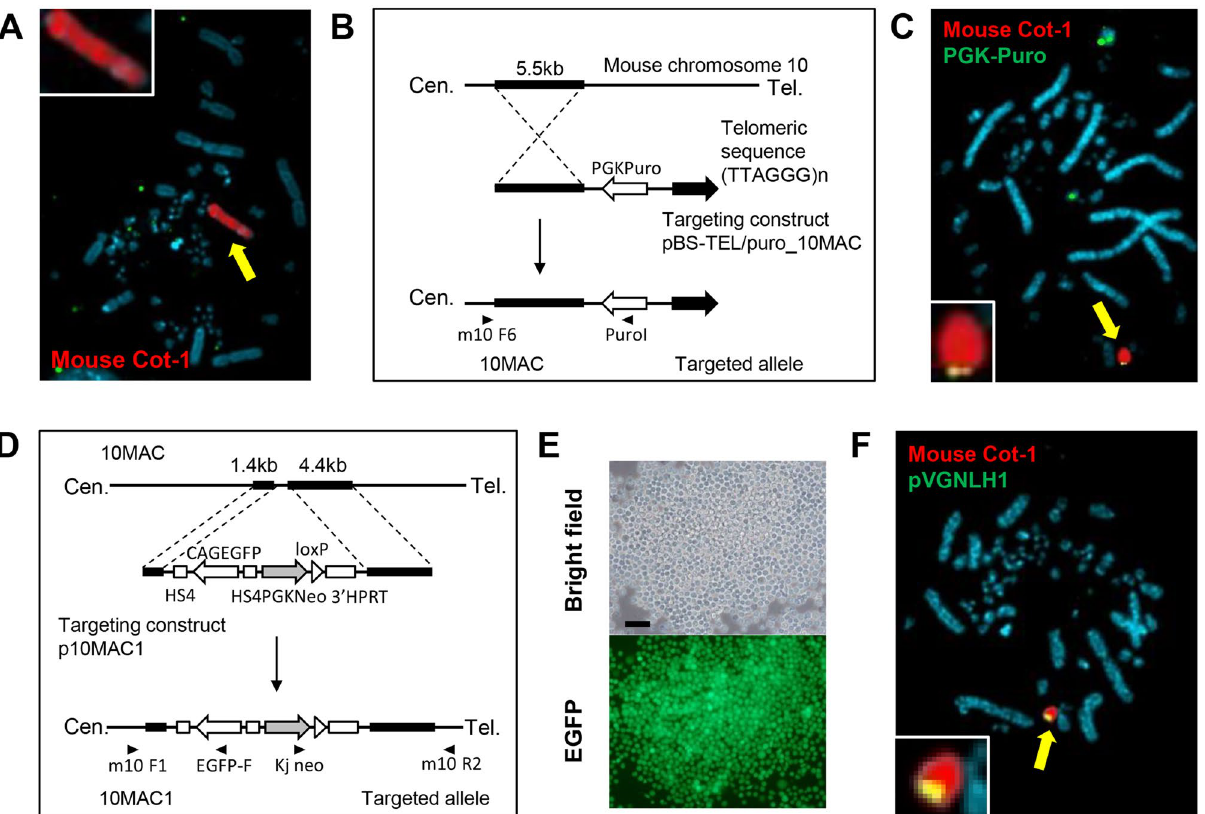
Figure 2. Strategy for the targeted truncation and construction of 10MAC1 vector. (A) Fluorescence in situ hybridization (FISH) analysis with a digoxigenin-labeled mouse Cot-1 DNA (red) identified the intact mouse chromosome 10 in the DT40 cells. The arrow indicates an intact mouse chromosome 10 and the inset shows an enlarged image. The chromosomal DNA was counterstained with DAPI, and DAPI was used for the same purpose in the following FISH experiments. (B) Strategy for the targeted truncation of the distal region of mouse chromosome 10 by the targeting vector, pBS-TEL/puro_10MAC. The telomere-seeding vector was electroporated into DT40 cells containing mChr.10-NeoR to yield puromycin-resistant transfectants. Arrowheads indicate genomic PCR primers. (C) A two-color FISH probe comprising the mouse Cot-1 DNA (red) that hybridizes with the 10MAC and puromycin-resistant gene (green) localized to the distal end of truncated 10MAC. The arrow indicates the MAC fragment, and the inset shows an enlarged image. (D) Strategy for the targeted integration of the EGFP gene, NeoR and loxP-3’HPRT into the 10MAC to construct 10MAC1 by the targeting vector, p10MAC1. Arrowheads indicate genomic PCR primers. (E) Electroporation of the pMAC1 plasmid yielded GFP-expressing, G418-resistant transfectants from the DT40 (10MAC1) cells. Phase-contrast (top panel) and fluorescence (bottom panel) micrographs are shown. Scale bar: 100 μm. (F) FISH analysis of the 10MAC1 vector in the DT40 (10MAC1) cells using the digoxigenin-labeled mouse Cot-1 DNA (red) and the biotin-labeled pVGNLH1 (green). The arrow indicates 10MAC1, and the inset shows an enlarged image of